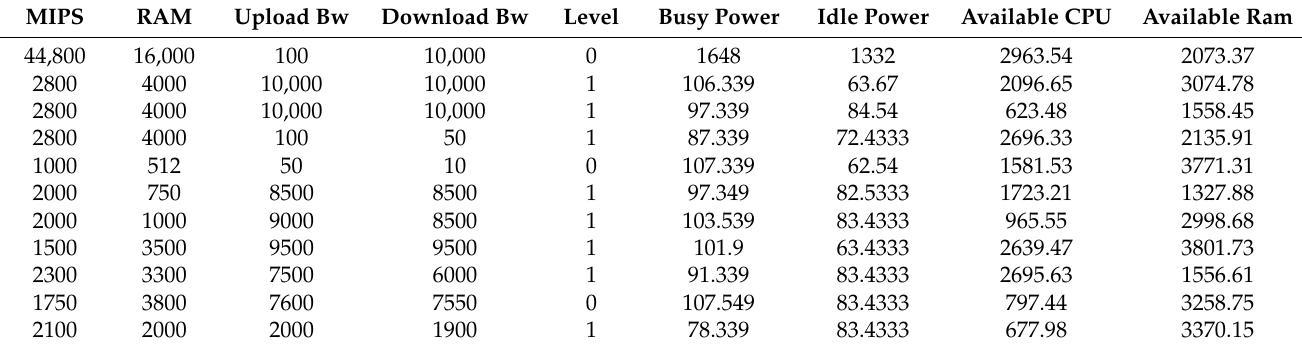
Table 4. Fog node